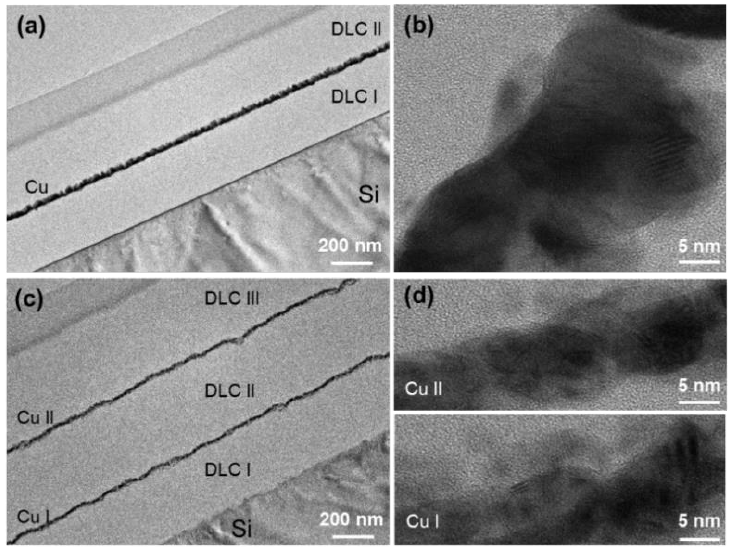
Figure 3. TEM ( a ) overview and ( b ) close-up view images of the 3-layer sample, DLC/Cu (50)/DLC, in group B. TEM ( c ) overview and ( d ) close-up view images of the 5-layer sample, DLC/Cu (25)/DLC/Cu (25)/DLC, in group C.